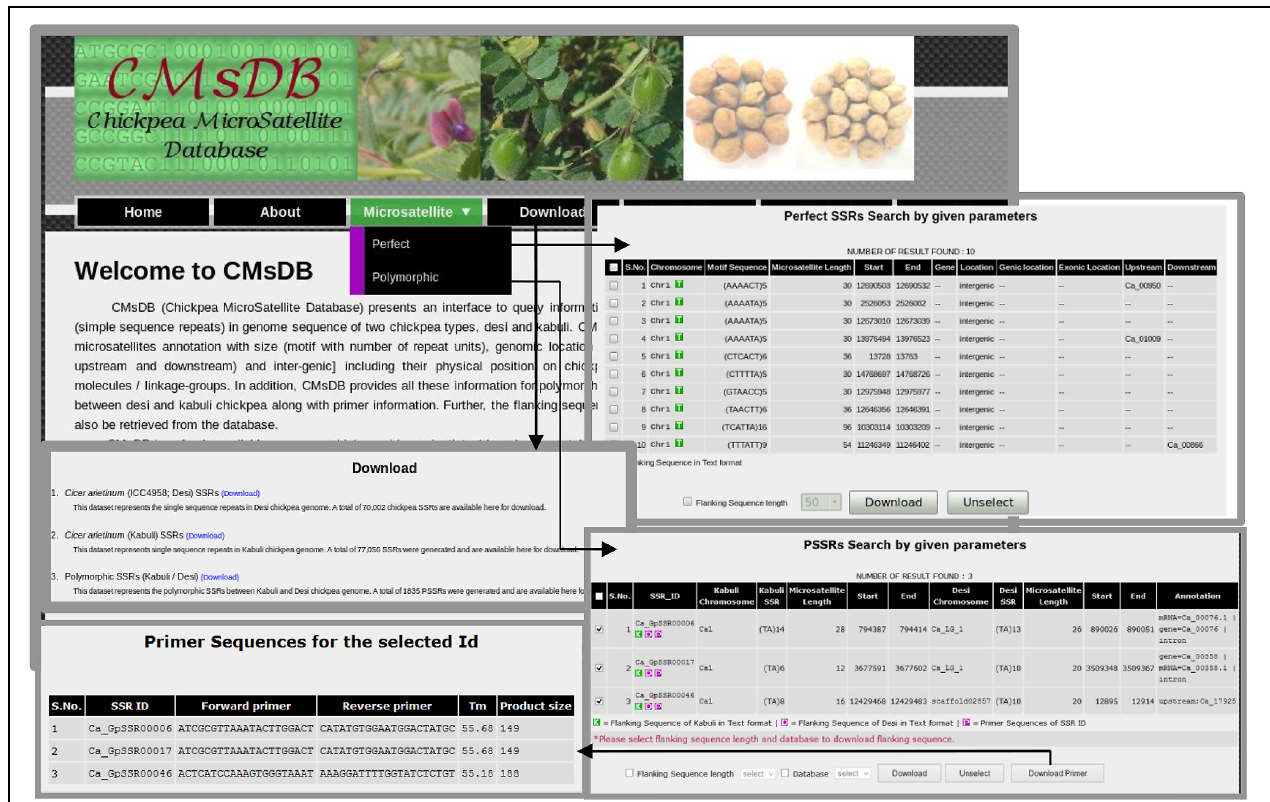
FIGURE 8 | Snapshots of the public web resource CMsDB showing its various utilities. The snapshots were taken from the database webpages.